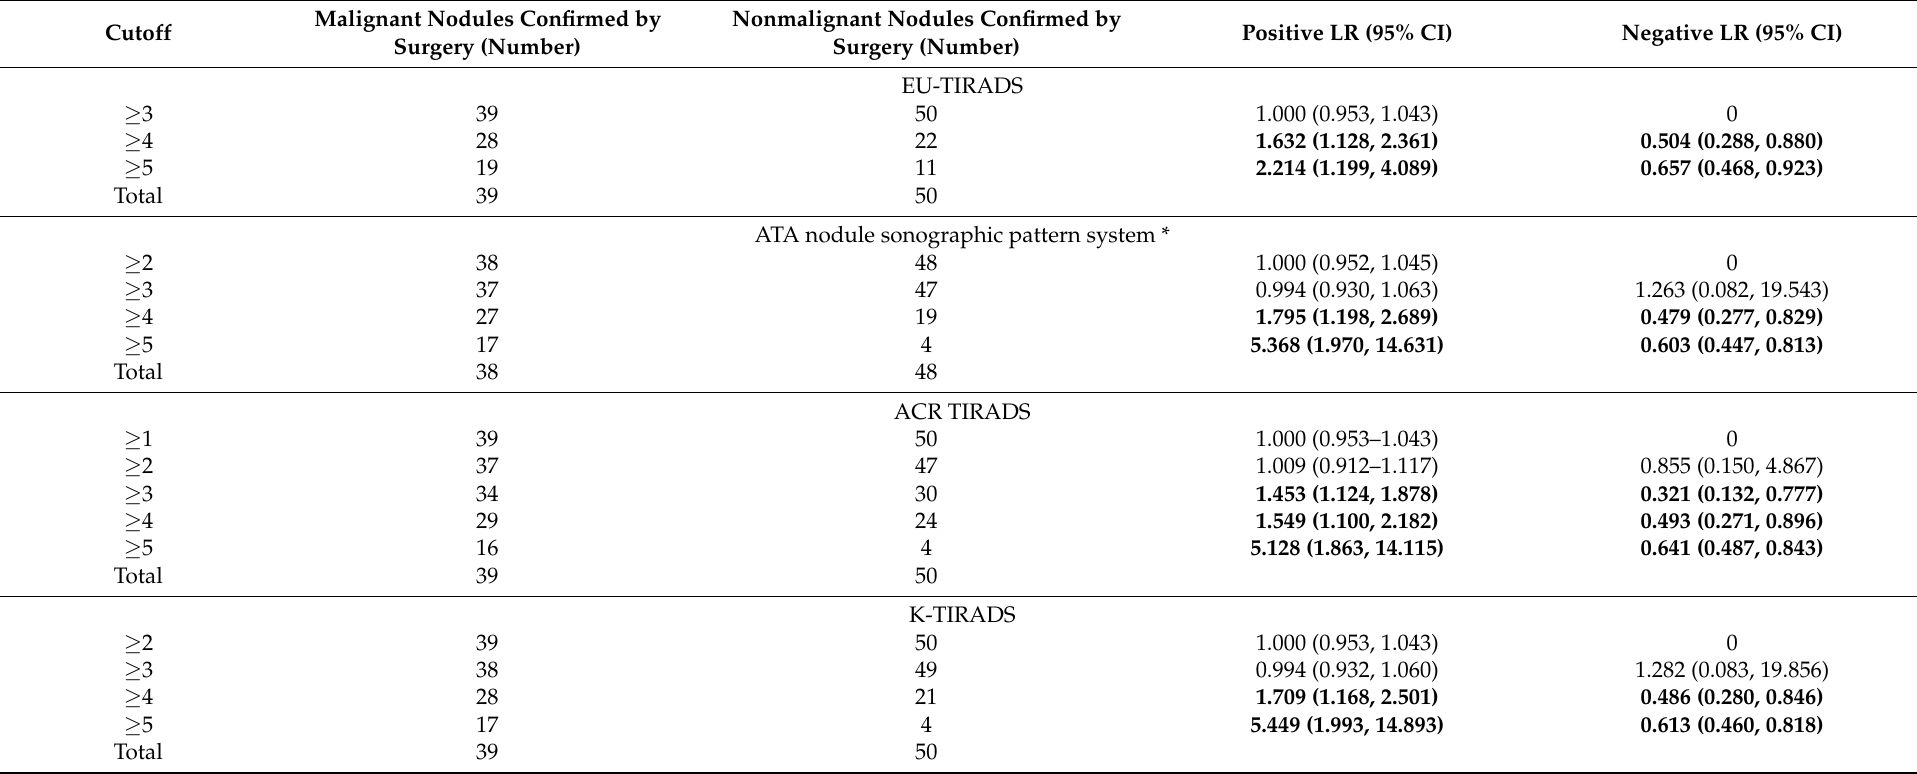
LR = likelihood ratio, TIRADS = Thyroid Imaging, Reporting and Data System, ATA = American Thyroid Association, ACR = American College of Radiology. * Nonapplicable cases (isoechoic nodule with one or more of the following features: irregular margins, microcalcification, taller-than-wide shape, rim calcification with small extrusive soft tissue component, and evidence of extrathyroidal extension) were excluded from analysis. Statistically significant values were